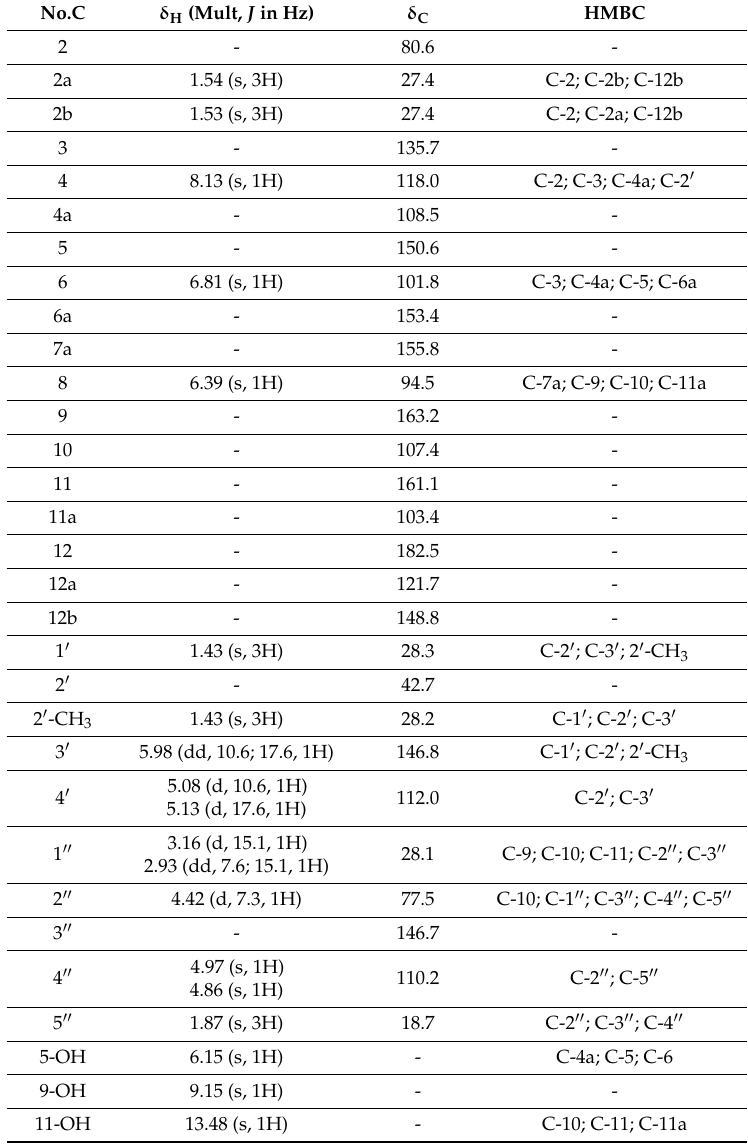
Table 1. NMR spectroscopic data of 5,9,11-trihydroxy-10-(2 ″ -hydroxy-3 ″ -methylbut-3 ″ -en-1-yl)- 2,2-dimethyl-3-(2 ′ -methylbut-3 ′ -en-2 ′ -yl)-2H,12H - pyrano[2,3-a]xanthen-12-one in CDCl 3 . No.C